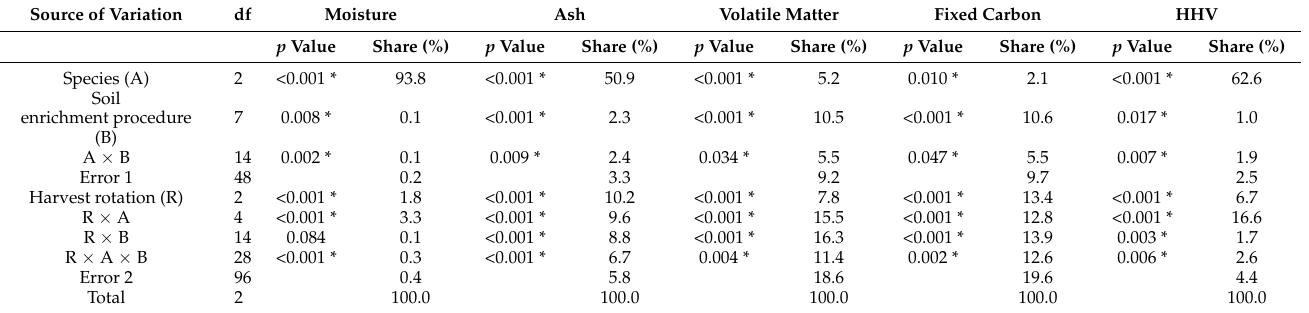
Table 1. Statistics of p values from the analysis of variance of the repeated measurements and the per- centage of the effects in the overall variance for the thermophysical characteristics of SRWC